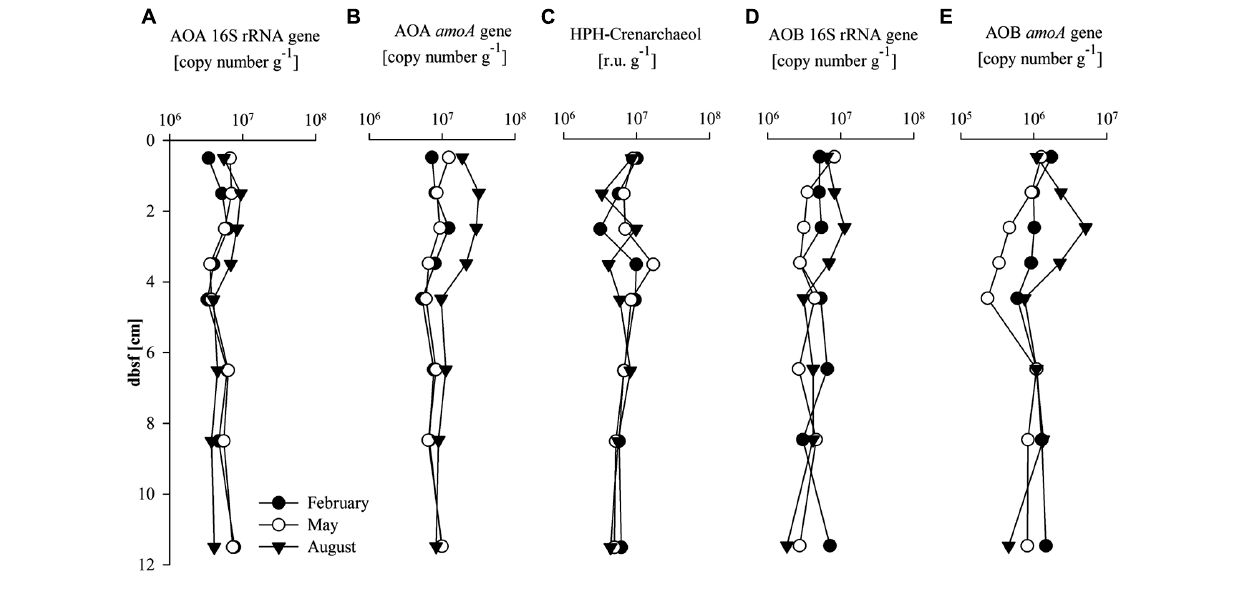
units g –1 ), and (D) AOB 16S rRNA gene (copy number g –1 ); (E) AOB amo A gene (copy number g –1 ) with sediment depth (cm) below sea floor